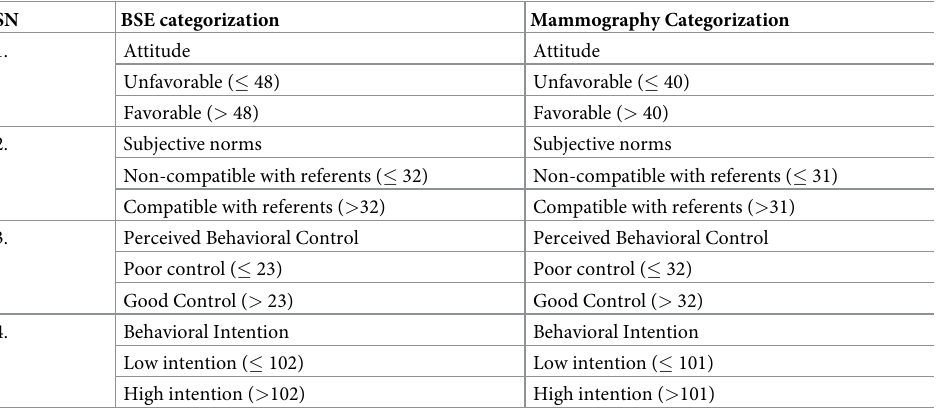
Table 1. Cut-off score and categorization of